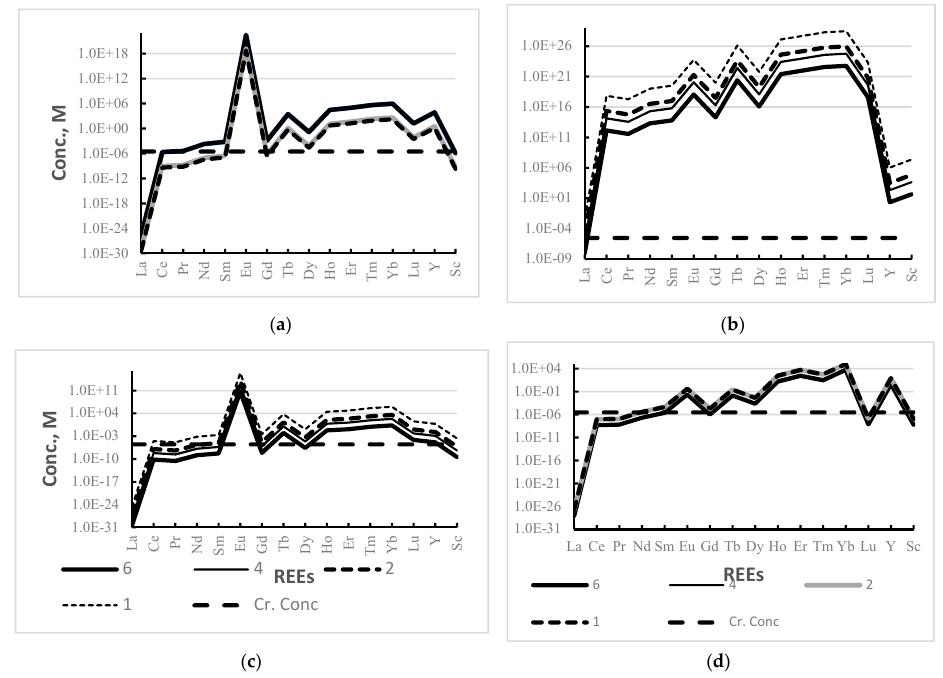
Figure 5. Concentrations of ( a ) Re 3 + , ( b ) ReCl 2 + , ( c ) Re(NO 3 ) 2 + , and ( d ) Re(SO 4 ) 2 − in equilibrium with octa-hydrated sulfate precipitate with 10 − 4 M of total concentration of sulfate in solution at pH 6, 4, 2, and 1. Cr. Concentration: 1 ppm line as a target concentration. Additional sulfate is provided by sulfuric acid in ( a ) and ( d